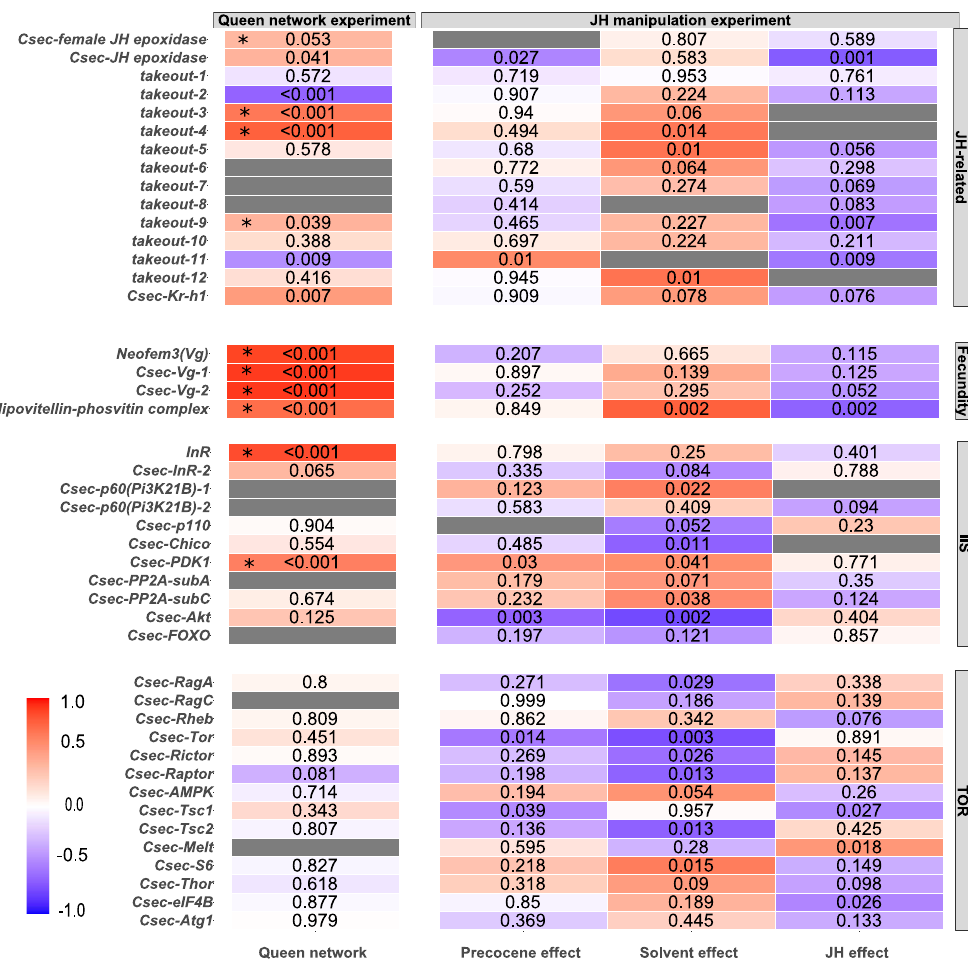
Fig. 3 Heatmap for the WGCNA results related with JH, fecundity, IIS, and TOR. Shown are the results of the co-expression analyses for the queen network experiment (column 1: queen network from queen – worker comparisons; n worker = 14; n queen = 14) and the JH-manipulation experiment with comparisons between precocene – control (column 2: precocene effect), the solvent – control (column 3: solvent effect), and the precocene – solvent